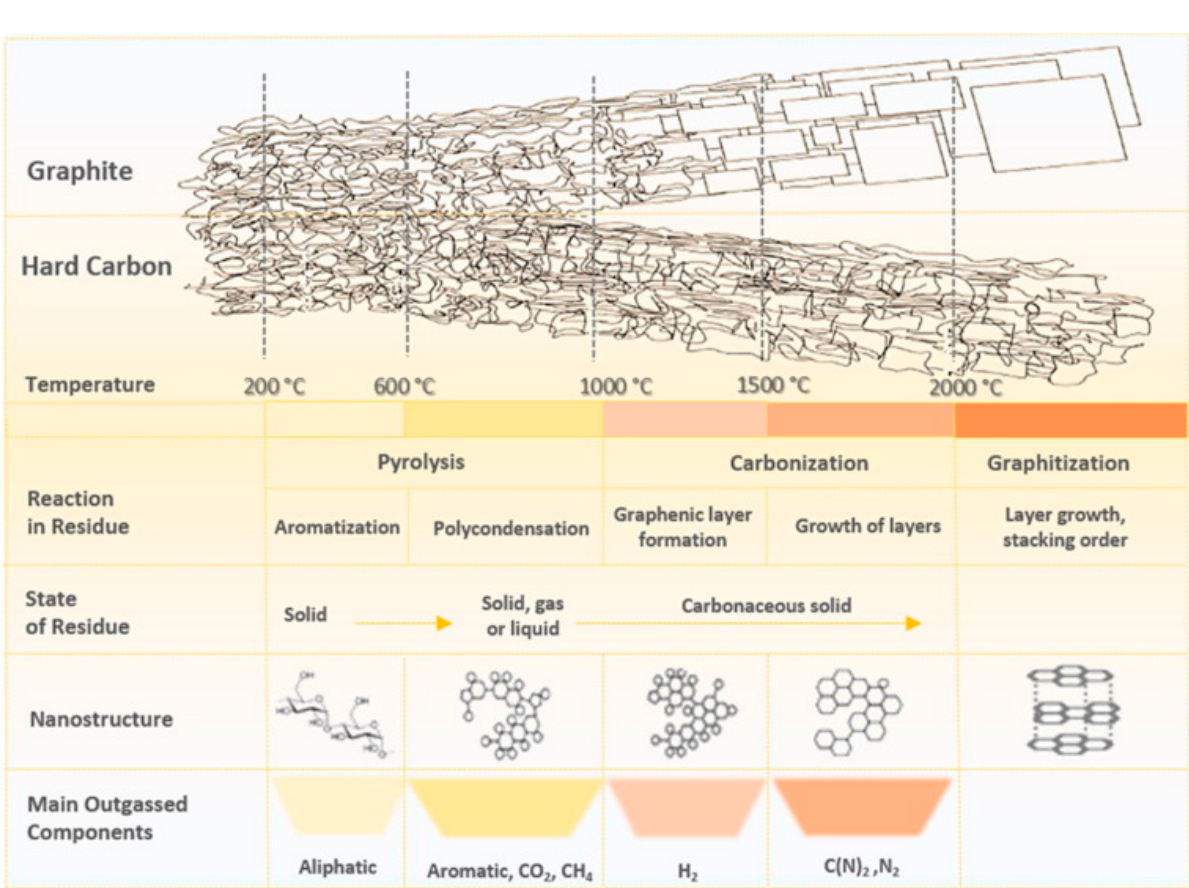
Figure 3. Hard-carbon formation scheme as a function of temperature [33] (Published in Materials Today, Volume 23, 2019,Dou (s), Hard carbons for sodium-ion batteries: Structure, analysis, sustainability, and electrochemistry, Pages 87–104, Copyright Elsevier (2023)).